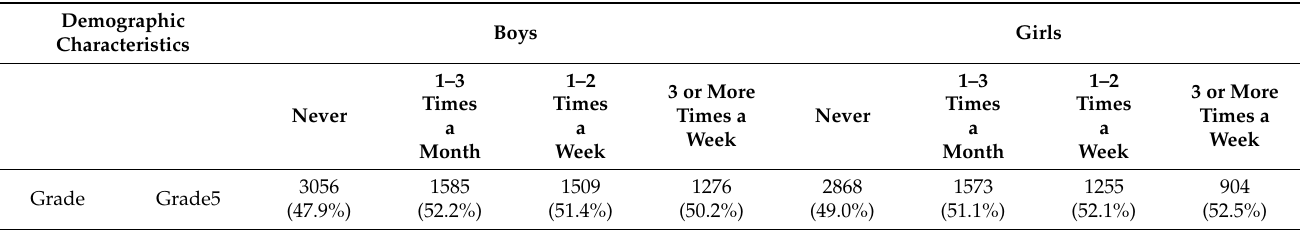
Table 2. Demographic characteristics of the participants according to sports participation frequencies and